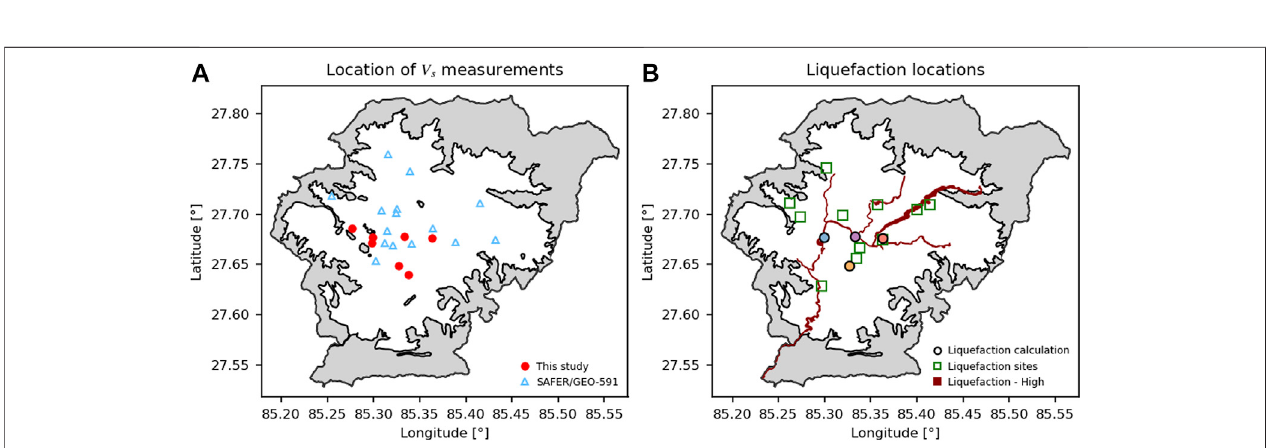
FIGURE12|(A) Contributionofstudyinincreasingthenumberofshear-wavemeasurements inthevalleytakenfromprevioussources described inSAFER/GEO- 591 (Gilder et al., 2019a; Gilder et al., 2020). (B) Comparison of locations with areas of known ground deformation or liquefaction from previous fi eld reconnaissance (Hashash et al., 2015) (green squares) and the areas of highest liquefaction from previous study. Liquefaction calculation locations correspond to later fi gures.